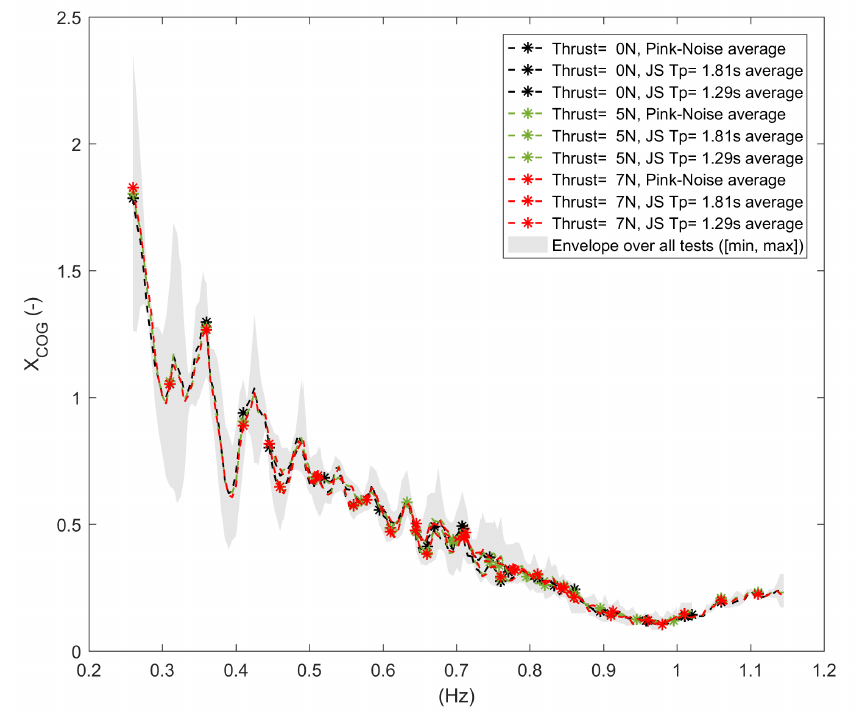
Figure 22. Surge RAOs for all irregular waves: average and envelope (min and